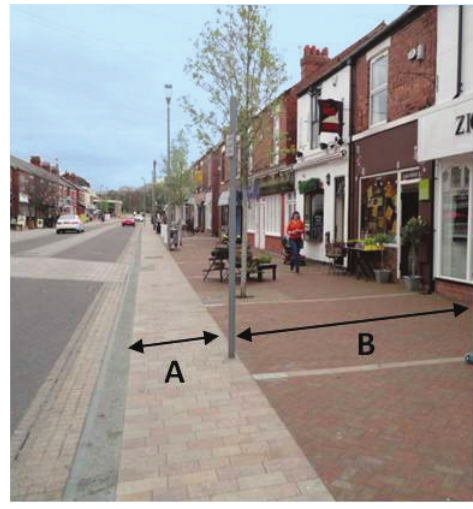
Figure 6. Pedestrian safe area in Park Lane